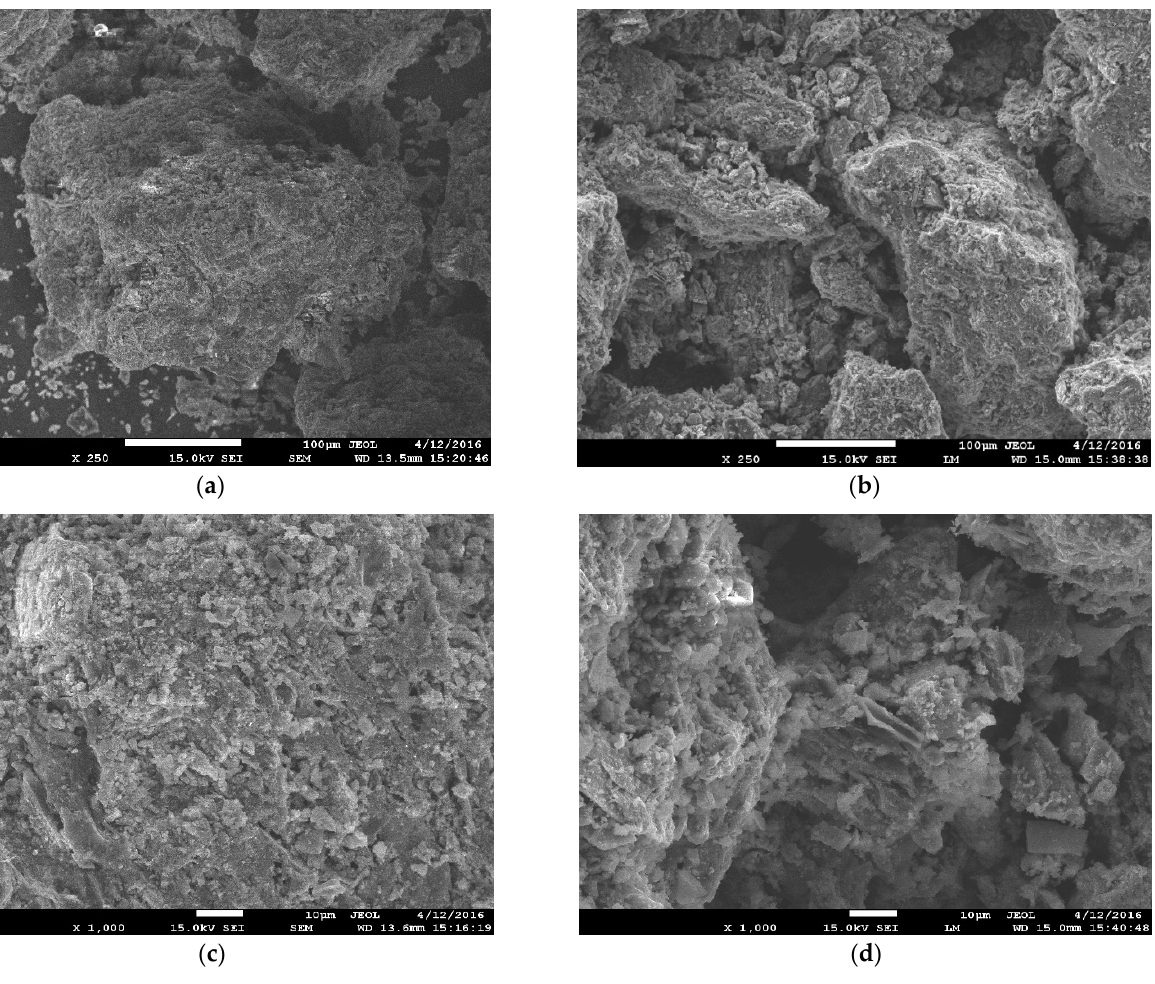
Figure 2. Microimages of PCM ( a , c ) and MPCM ( b , d ) obtained by scanning electron microscopy at 250× ( a , b ) and 1000× ( c , d ).